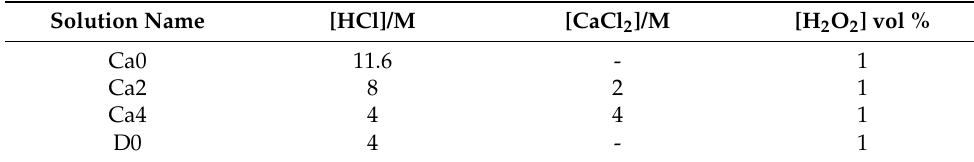
Table 3. Chemical composition of the leaching solutions used in this